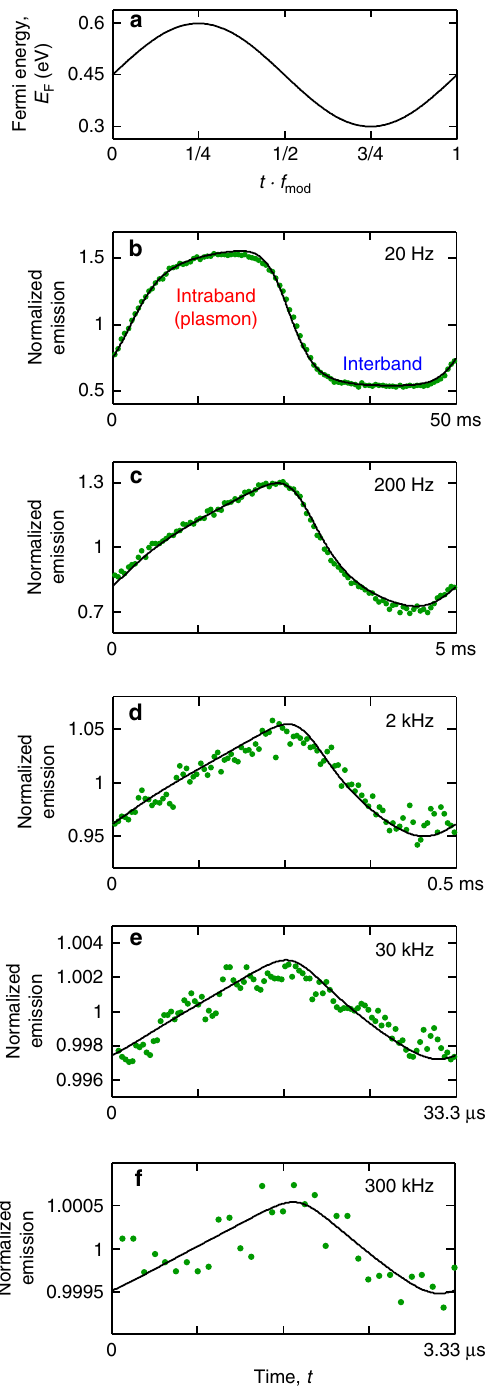
Fig. 3 Dynamic modulation between interband and intraband regimes. a Fermi energy as a function of time t using a sinusoidal function of frequency f E F ~0.45eV, whereas the mod (schematic). The slow topgate is used to tune to fast backgate provides the modulation between 0.3 and 0.6eV. b – f Time- resolved photon emission while the Fermi energy is modulated at different frequencies between 20Hz and 300kHz (green dots). Every time-modulated emission measurement is normalized to its mean value, so that the modulation does not depend on the excitation laser power or the photon collection ef fi ciency. The black solid curves show the dynamic simulations of N ions located at the distribution of distances from graphene P ( z ), obtained from the emission contrast measurements and decay curves (see “ Methods ” ). Note that f shows modulation on a time scale of microseconds, whereas the radiative lifetime of erbium ions in Y 2 O 3 is ~10ms, a difference of 4 orders of